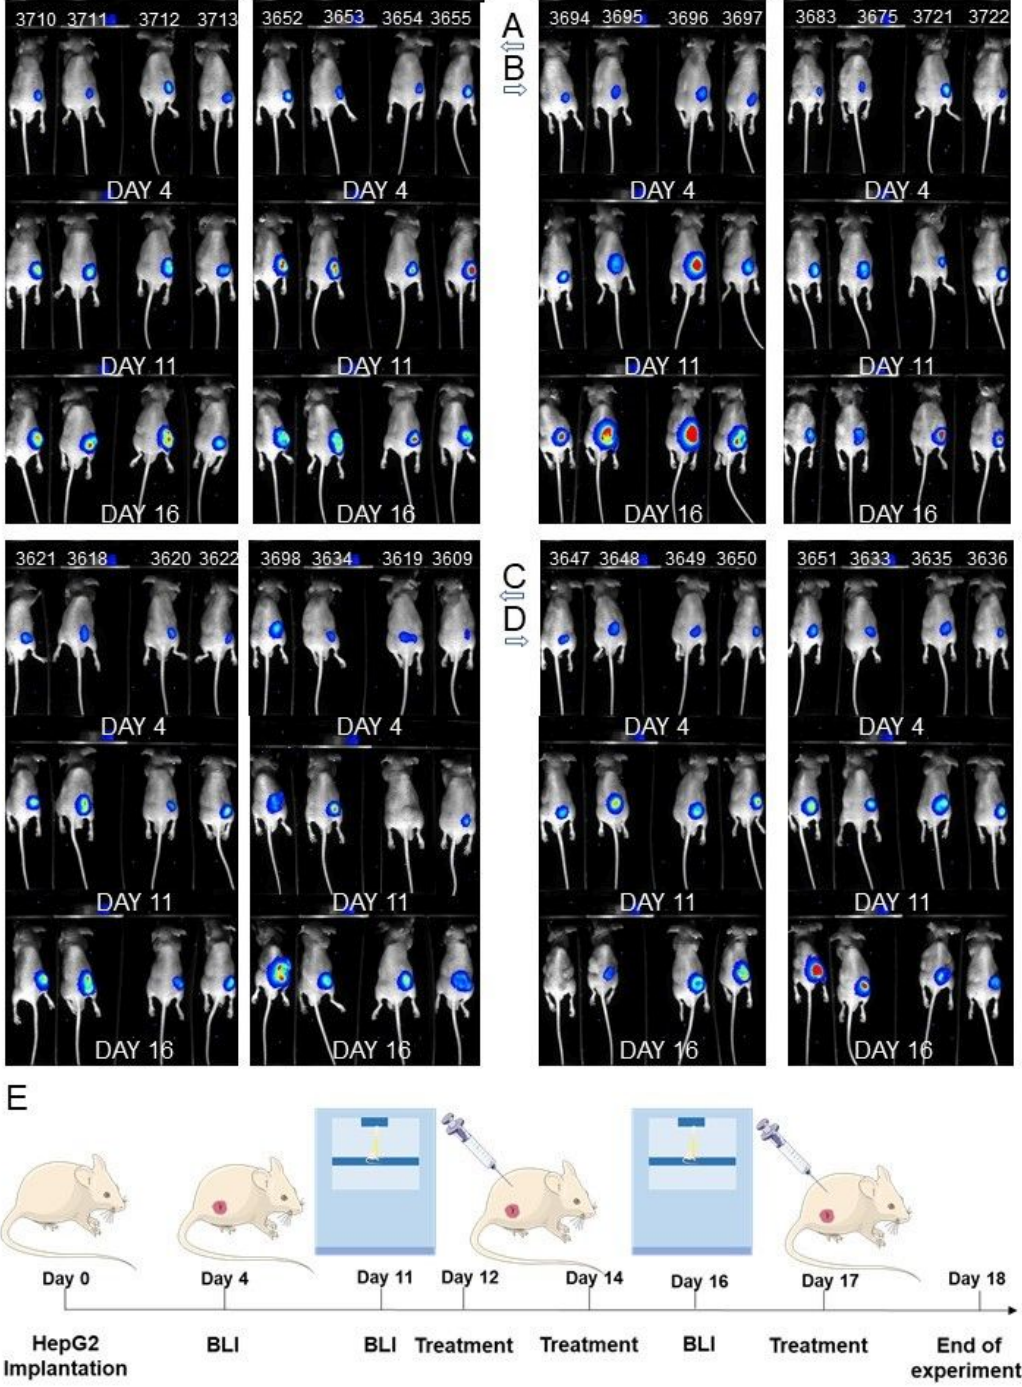
Figure 13. Effect of tested compounds on the tumor burden in BALB/c nude mice with HepG2 cancer xenografts. Control mice are shown in Panel ( A ), while the Xanthohumol-treated (40 mg/kg b.w.) group is presented in panel ( B ). The group treated with PEITC (15 mg/kg b.w.) on panel ( C ) and the group treated with Xanthohumol + PEITC on panel ( D ). The series of photographs show luminescence at days 4, 11, and 16, as is presented in panel ( E ). The luminescence signal measured in each mice (marked with ear tags’ number) is also shown in Figure 13.